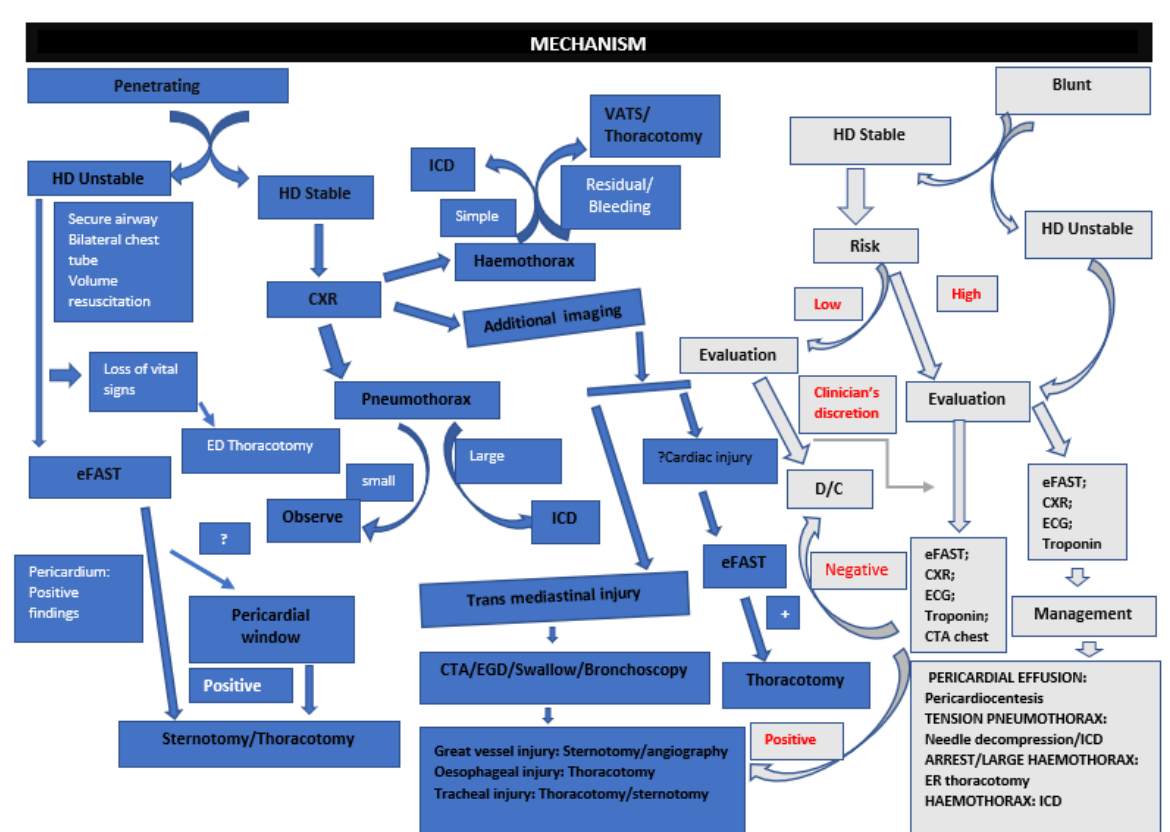
Figure 4. Suggested algorithm for approach to chest trauma. HD—Haemodynamically; ED—Emergency department; eFAST—Extended focused assessment with sonography for trauma; “?”—Not conclusive; CXR—Chest X ‐ ray; ICD—Intercostal chest drain; VATS − Video ‐ assisted thoracoscopy; CTA—Computed tomography angiogram; EGD—Esophagogastroduodenoscopy.